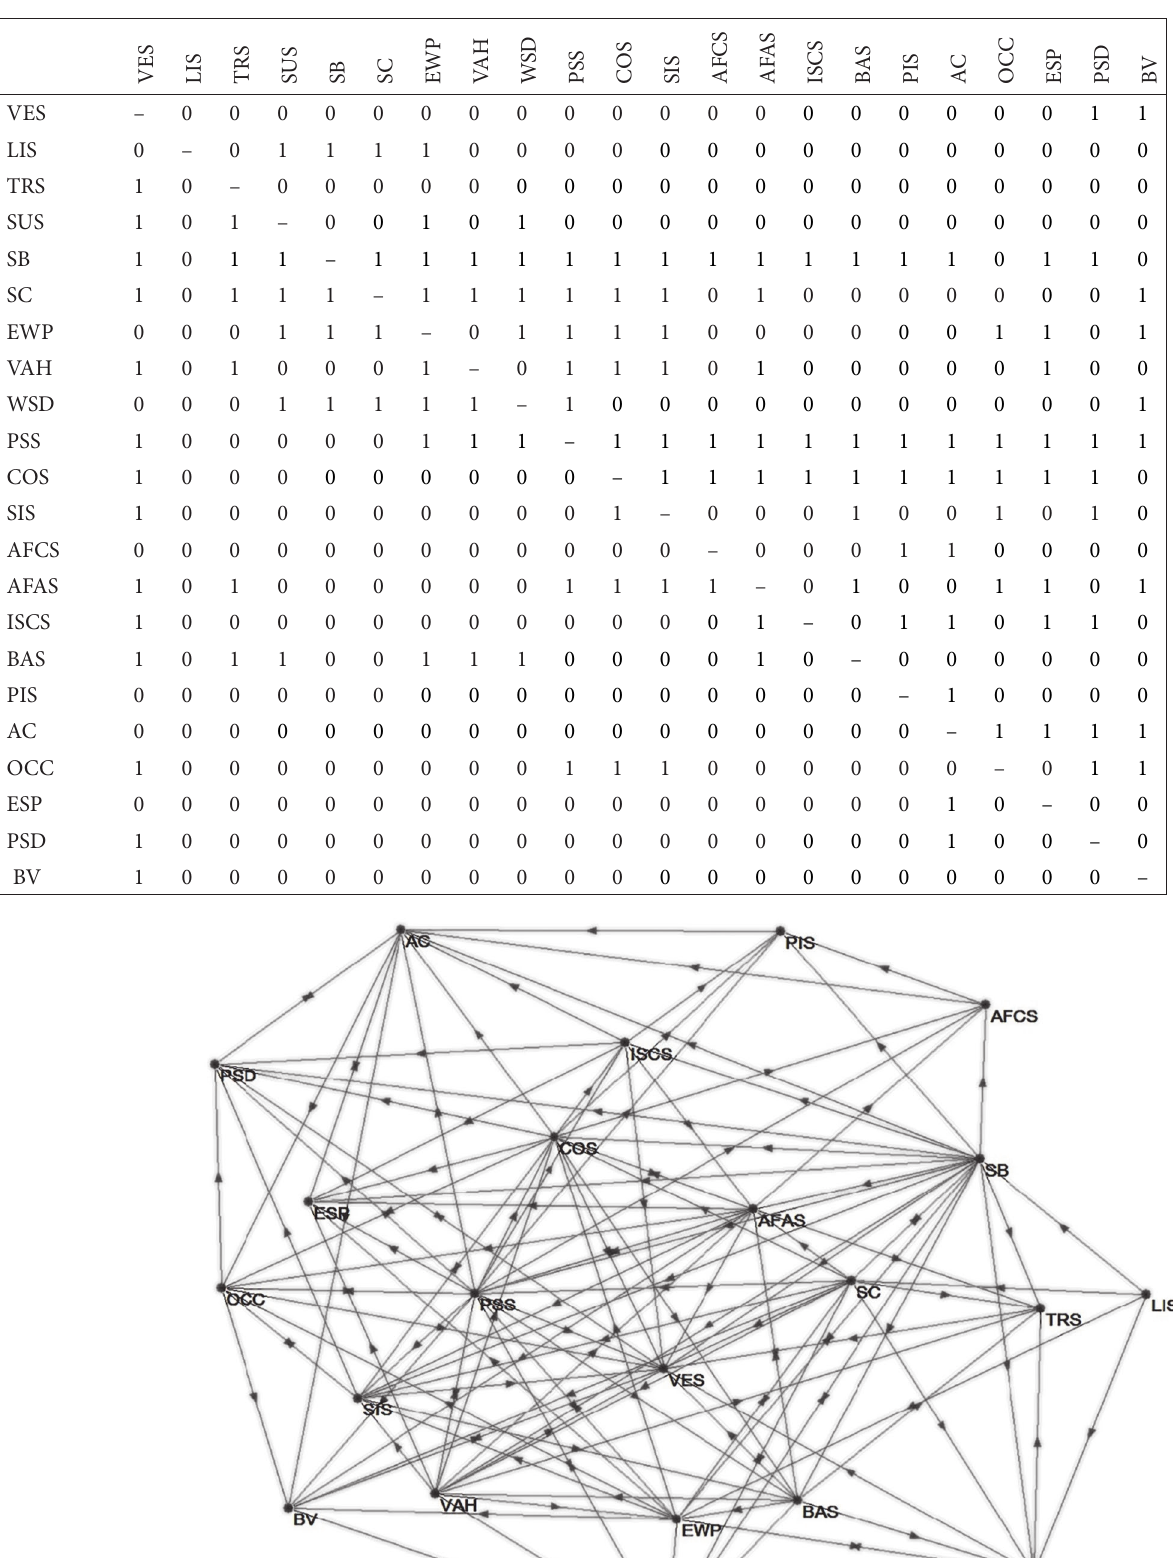
Table 4. Matrix of the interdependence of subway subsystems